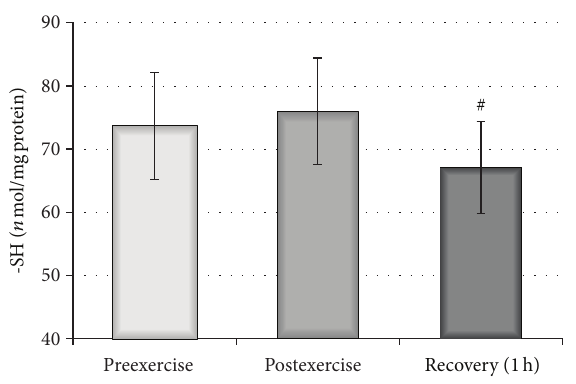
Figure 5: Effect of physical exercise on reducing potential of plasma estimated before, after, and 1 hour after physical exercise. ∗ indicates significant difference between preexercise and 1 hour recovery ( 𝑃 < 0.0002 ); # indicates significant difference between postexercise and 1h recovery ( 𝑃 < 0.001 ).